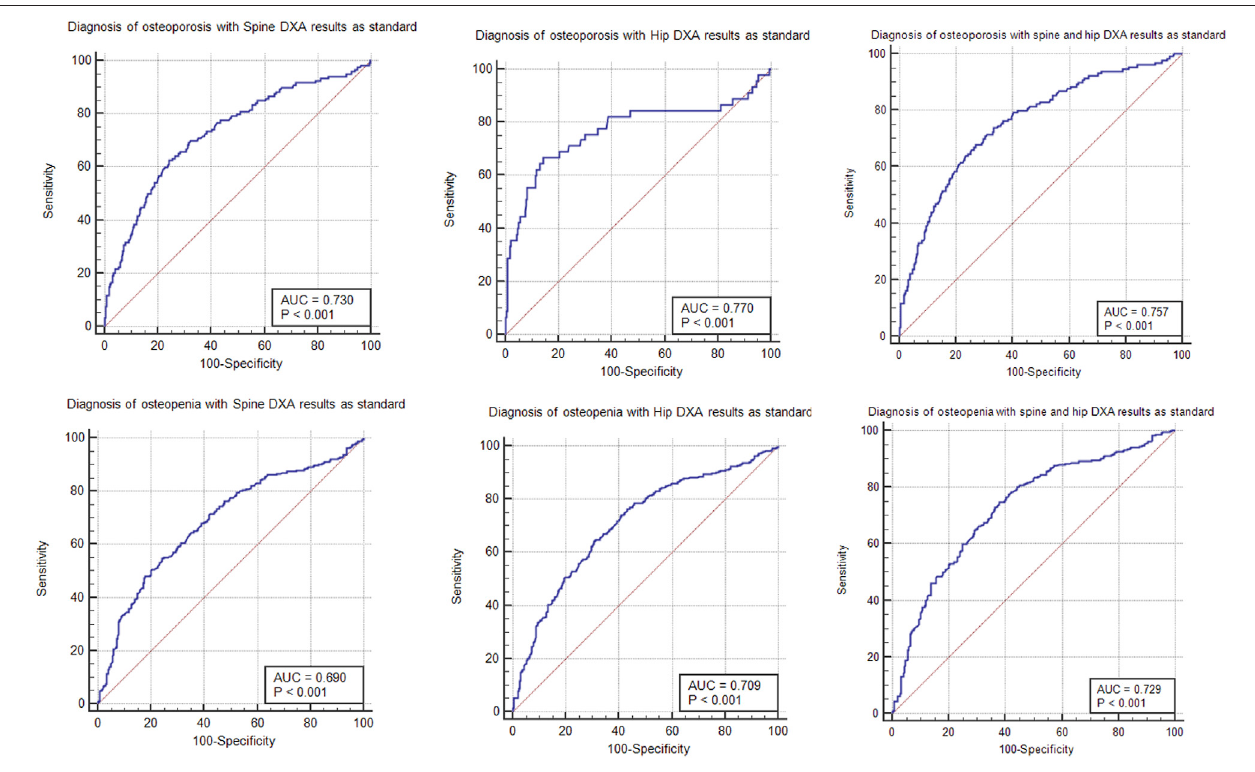
FIGURE 6 | ROC analysis of PL-QCT and DXA diagnosis result comparison.